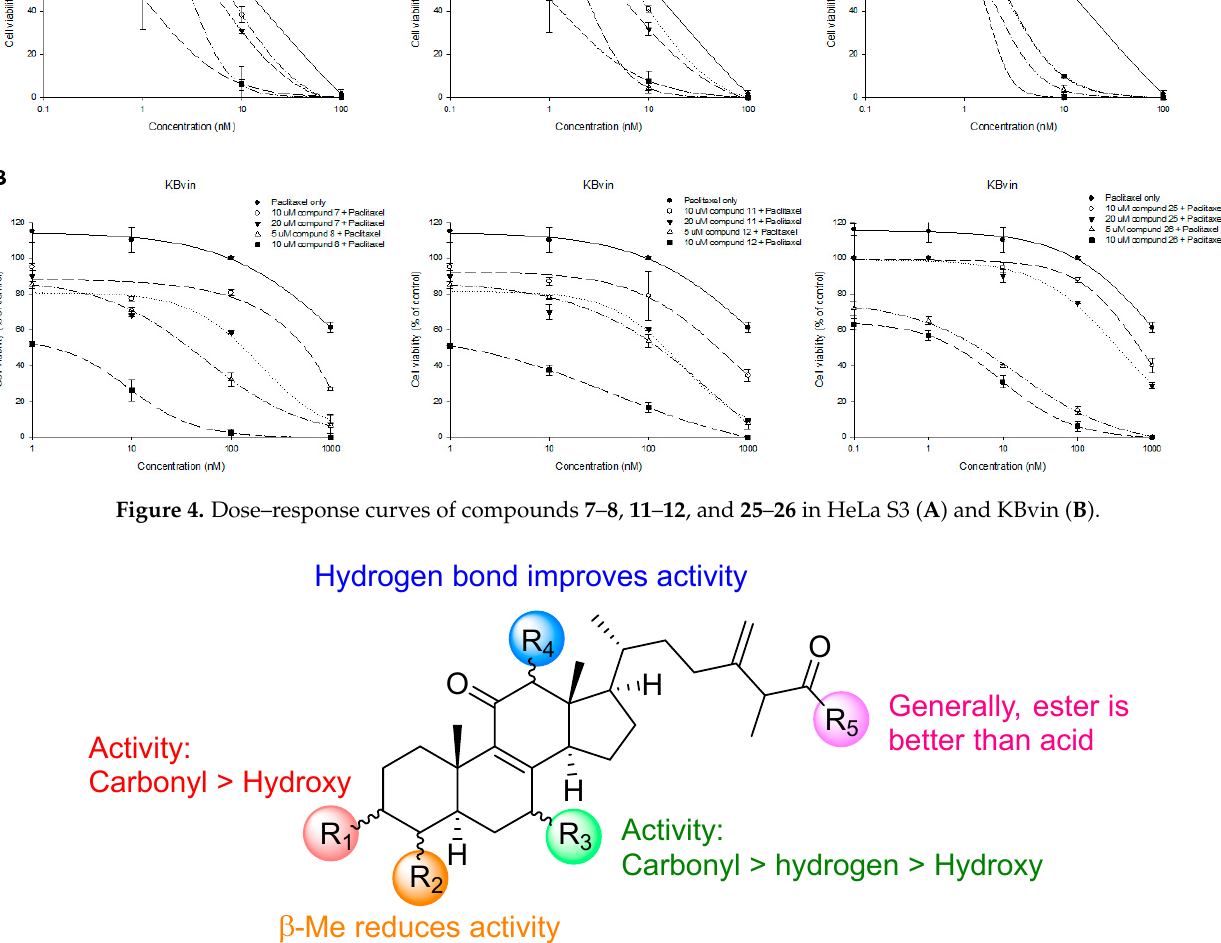
Figure 5. Summary of the SAR of all triterpenes in terms of collateral sensitivity.